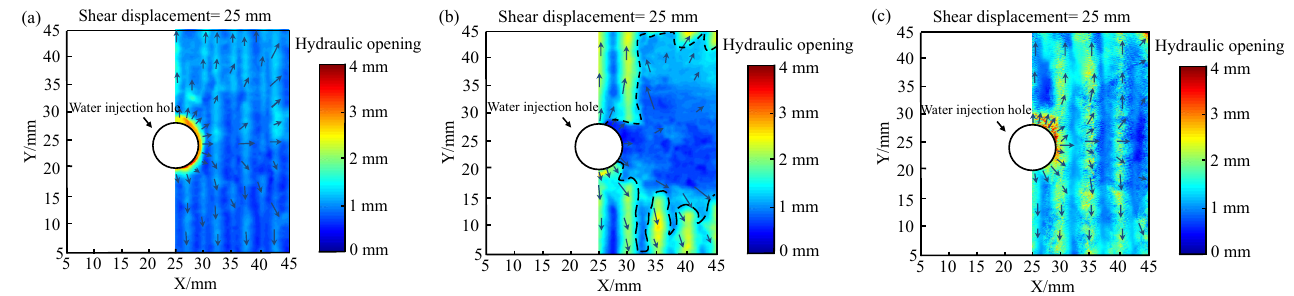
Figure 13. Hydraulic opening diagram of the structural plane (shear displacement 25 mm) at fluctuations angles of ( a ) 15°, ( b ) 30°, and ( c ) 45°.